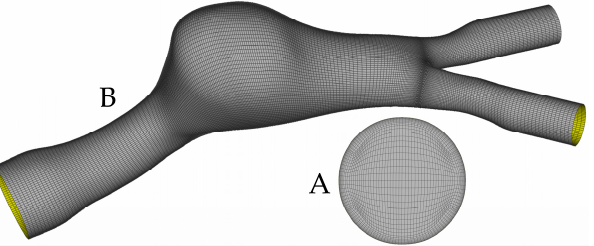
Figure 1. ( A ): Inlet mesh and O-Grid for the construction of boundary layer. ( B ): Surface mesh of the aneurysm and bifurcation area, where it can be seen that the mesh density increases while moving close to the bifurcation, in order to capture non-trivial flow dynamics.